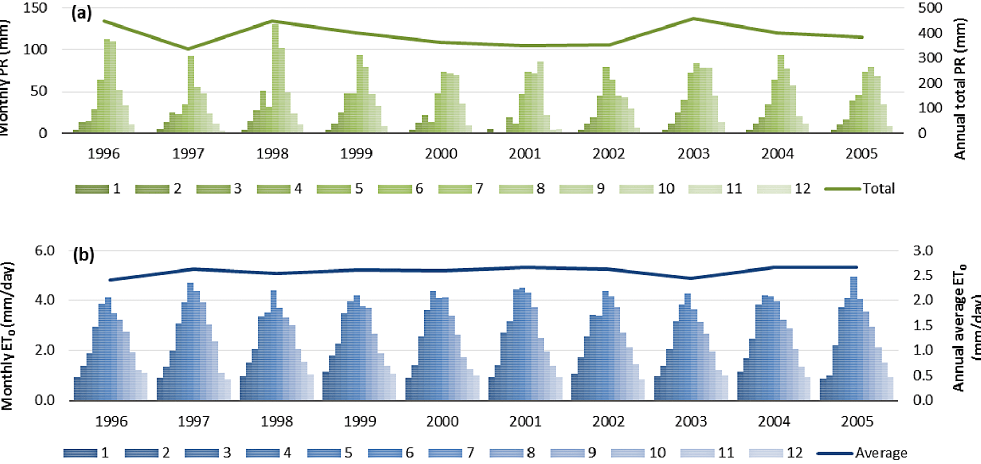
Figure 2. Monthly precipitation (PR) and monthly averages of daily reference evapotranspiration (ET 0 ) in the Yellow River basin from the CRU-TS database, for the period 1996–2005.